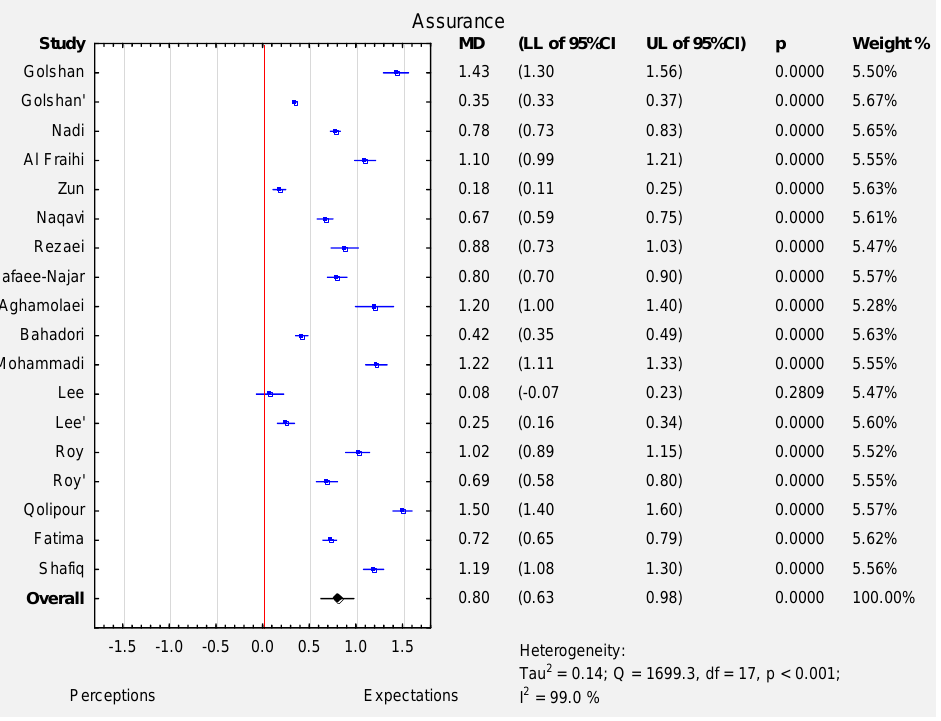
Figure 5. Forest plot for the mean difference ([MD]; 95% CI) of patients’ perceptions and expectations in the assurance dimension. According to random effect meta-analysis (I-squared index 99.0%, p < 0.001) the pooled estimate of MD was 0.75 (95% CI: 0.57 – 0.92), which indicated that the expectations of all participants were significantly higher than their perceptions ( p < 0.001) in the empa- thy dimension. The MD varied from −0.03 (Lee et al. [12]-patients) to 1.56 (Golshan et al. [16]-urolithiasis adherence patients) (see Figure 6). The funnel plot (Supplementary Ma- terial s) and results of Egger’s test indicate evidence of publication bias in some of the studies (t = 2.95, p < 0.01).